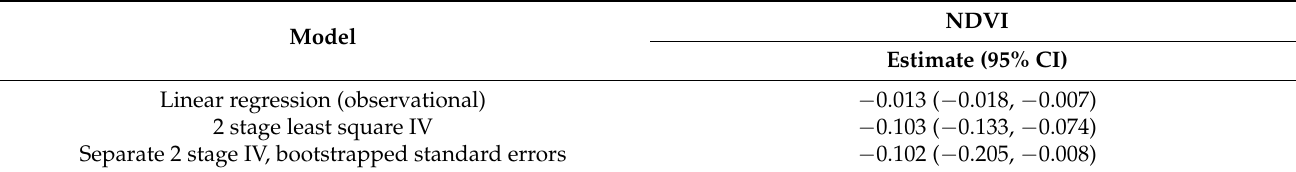
Table 8. Linear regression and instrumental variable (IV) estimates for the effect of episodic memory on neighborhood Normalized Difference Vegetation